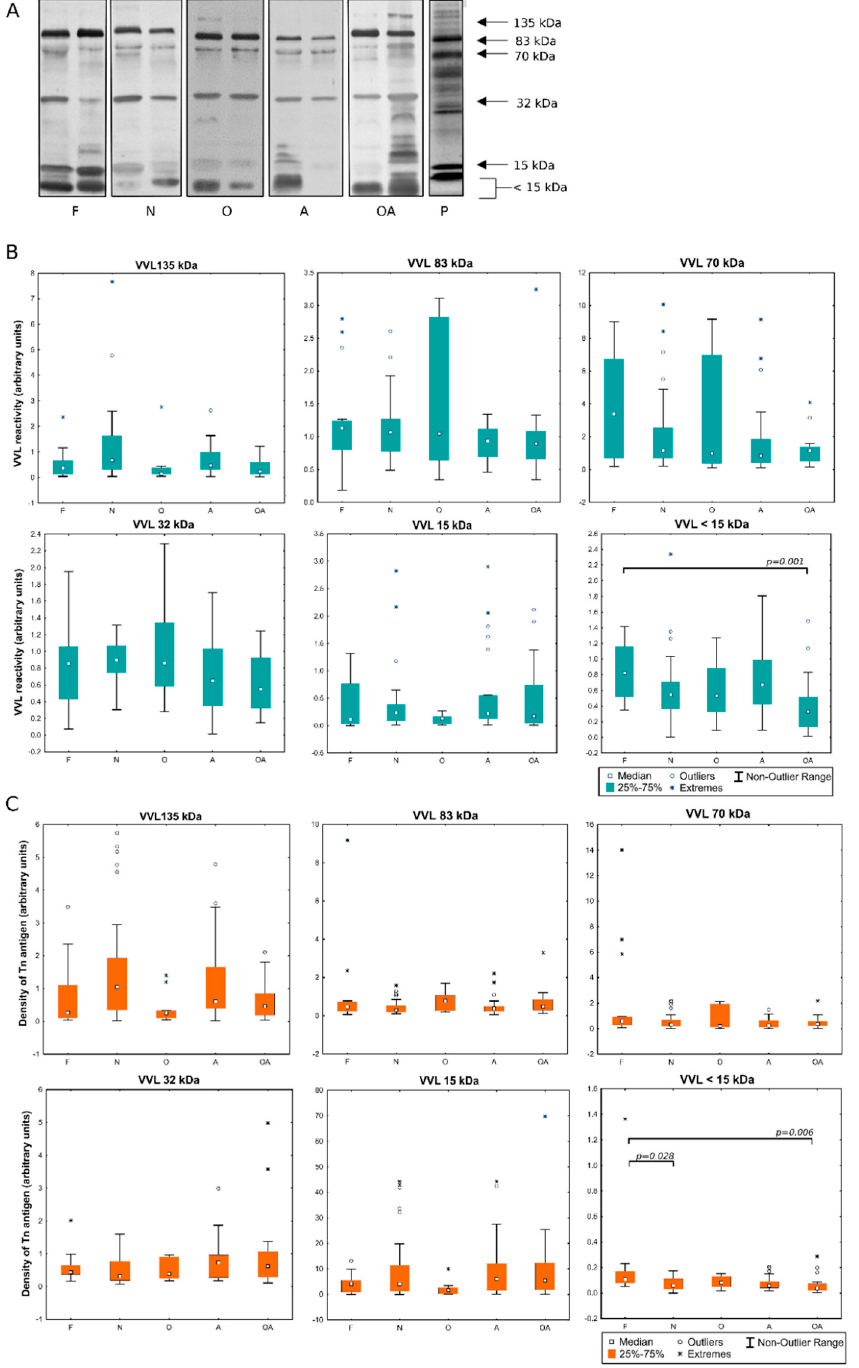
Figure 2. Vicia villosa reactivity of seminal plasma. ( A )—representative lectin-blotting patterns of individual samples classified to different diagnostic groups: F: normozoospermic fertile (control); N: normozoospermic non-fertile; O: oligozoospermic; A: asthenozoospermic; OA: oligoasthenozoosper- mic; P: SDS-PAGE seminal plasma protein bands stained with SyproRuby (negative); ( B )—total reactivity in the selected bands measured as densitometric analysis; ( C )—density of VVL-detected glycans calculated as VVL/protein